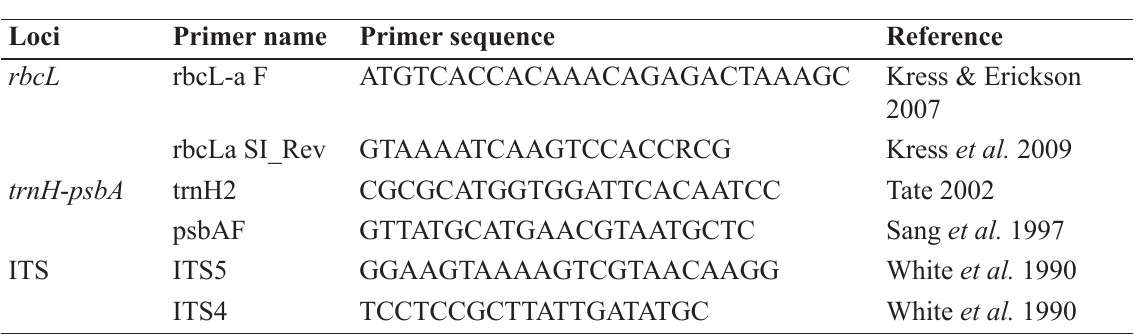
Table 1. Primers used in this